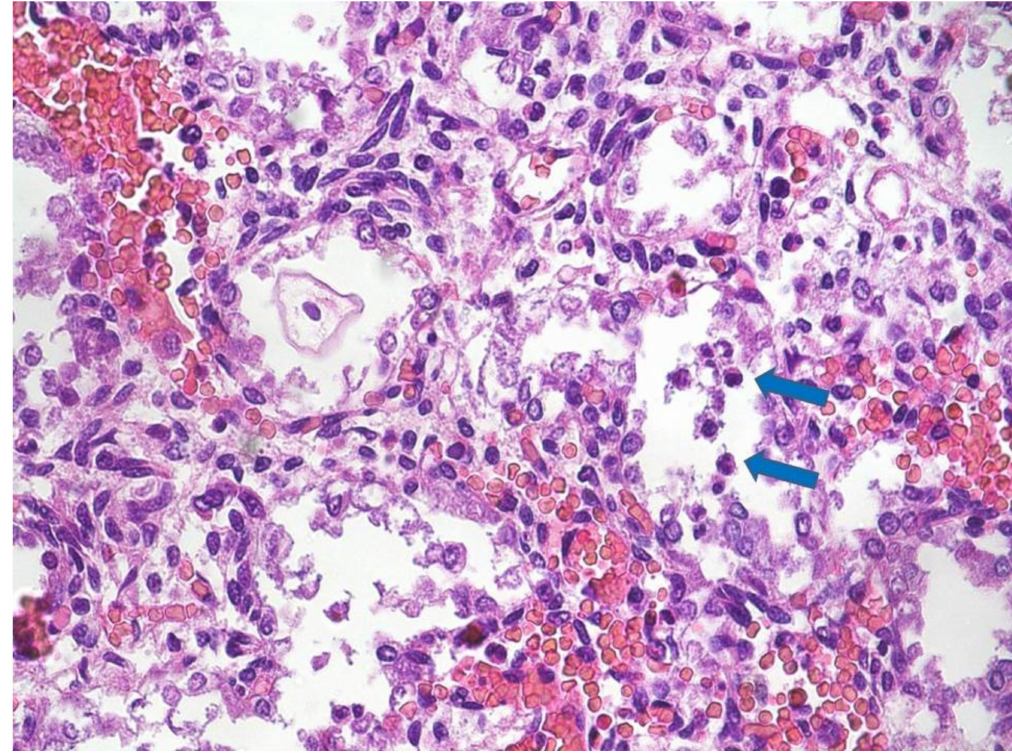
Figure 1. Fetal lung: A few neutrophils within the alveoli (blue arrows; Hematoxylin Eosin (HE) staining 20 ×